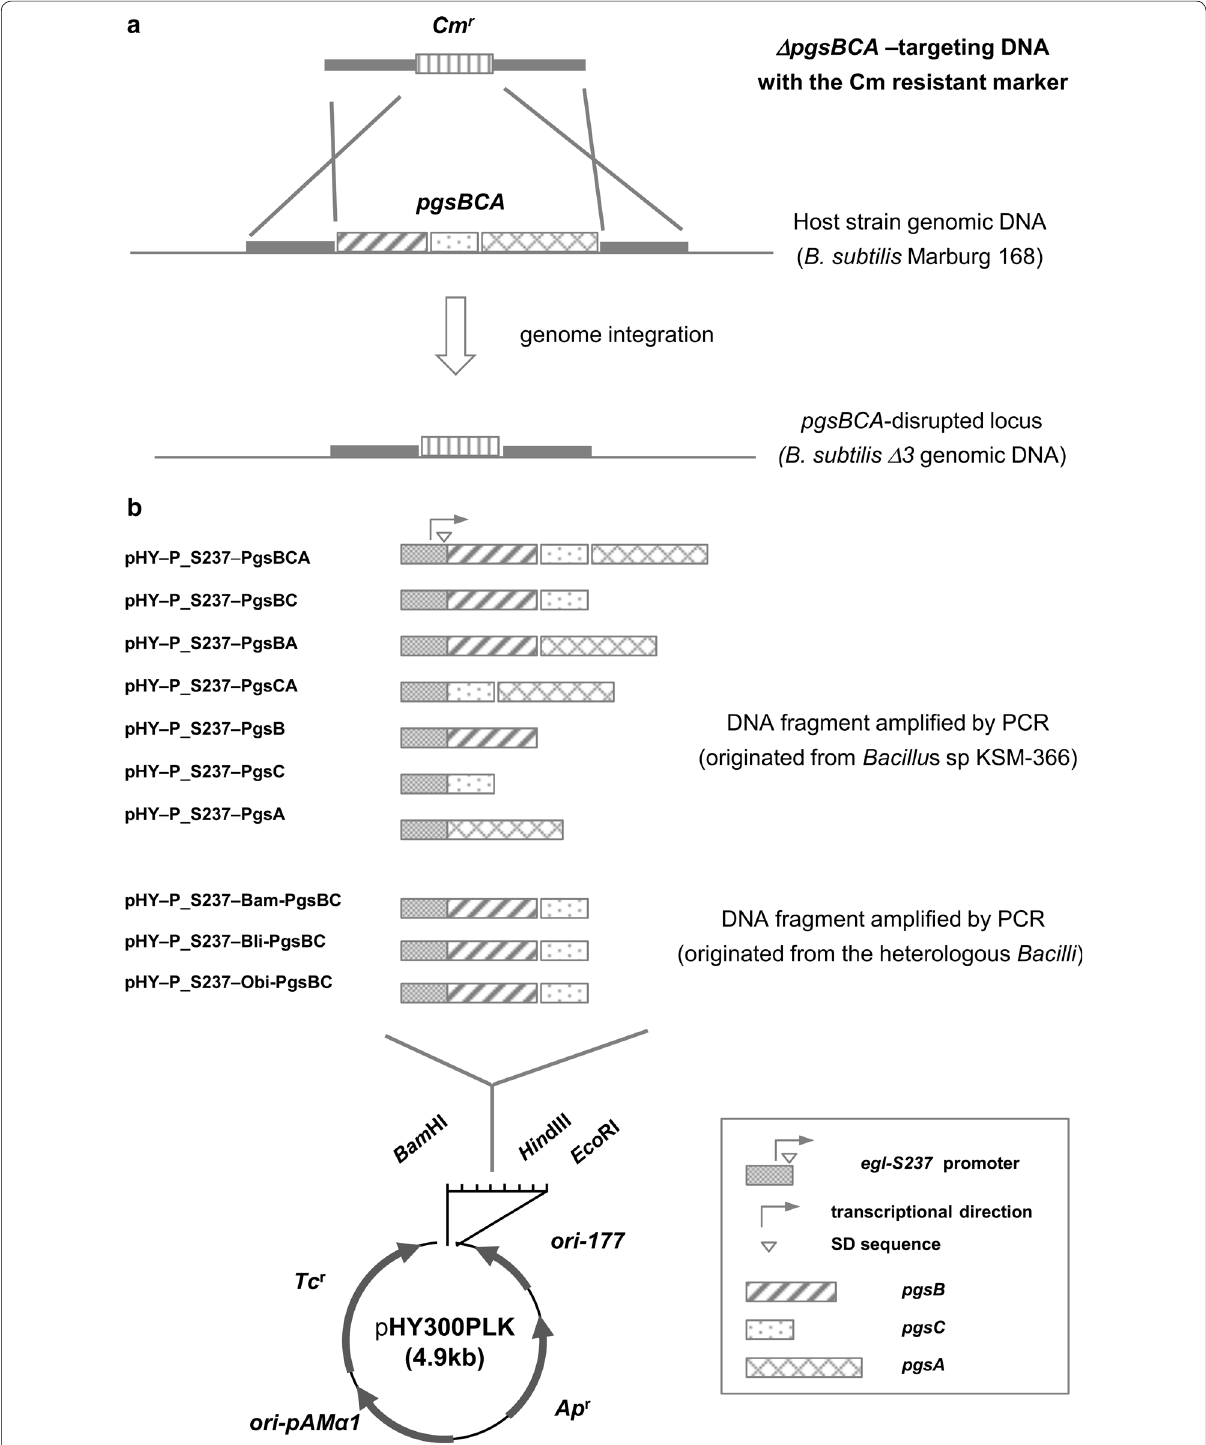
Fig. 1 Construction of pgsBCA deletion mutants and pgs -gene expression vectors. a Deletion of pgsBCA genes from B. subtilis Marburg No.168 by double crossover homologous recombination. b Construction of pgs -gene expression vectors. DNA fragments ( pgsBCA – pgsA ) were amplified using spliced overlapping-extension (SOE)-PCR and were cloned into the plasmid pHY300PLK using restriction enzyme digestion. The heterologous Bacillus pgsBC fragments Bam-pgsBC, Bli-pgsBC, and Obi-pgsBC were then cloned using an in-fusion recombination cloning